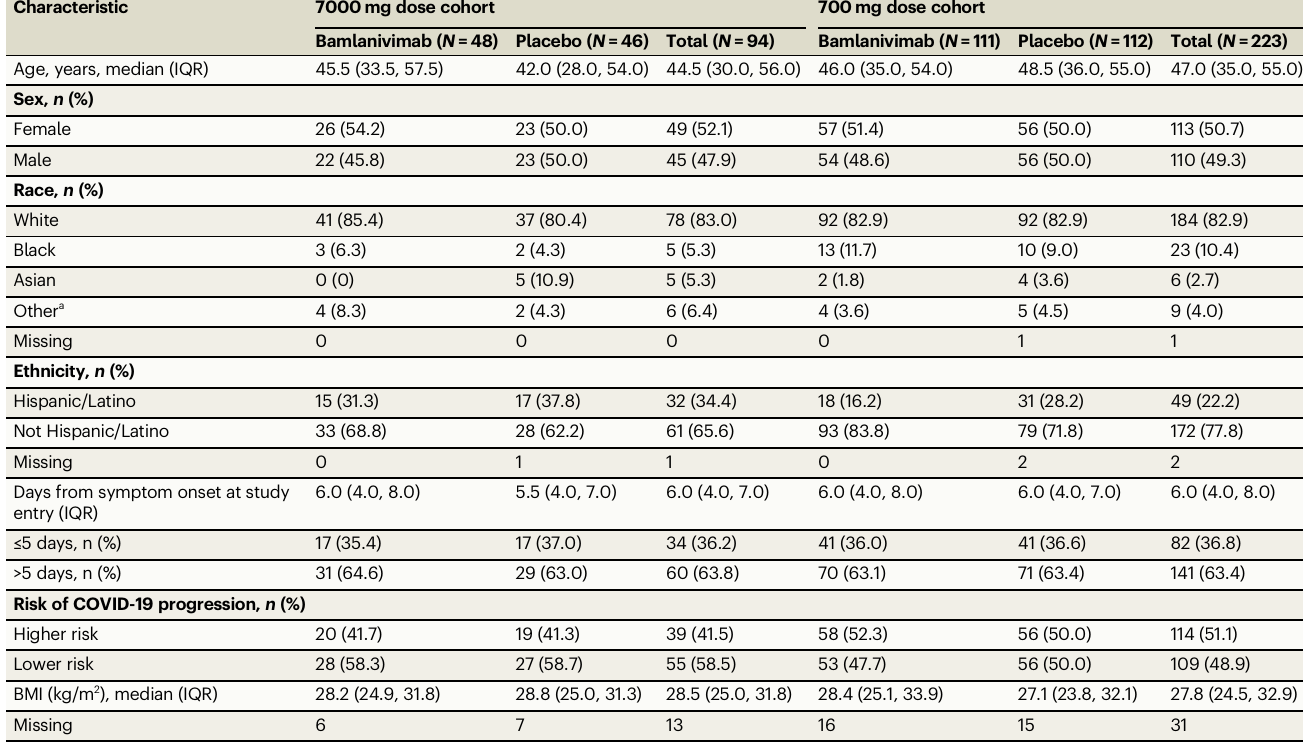
Table 1 | Baseline participant characteristics by dose cohort and treatment arm Characteristic 7000mg dose